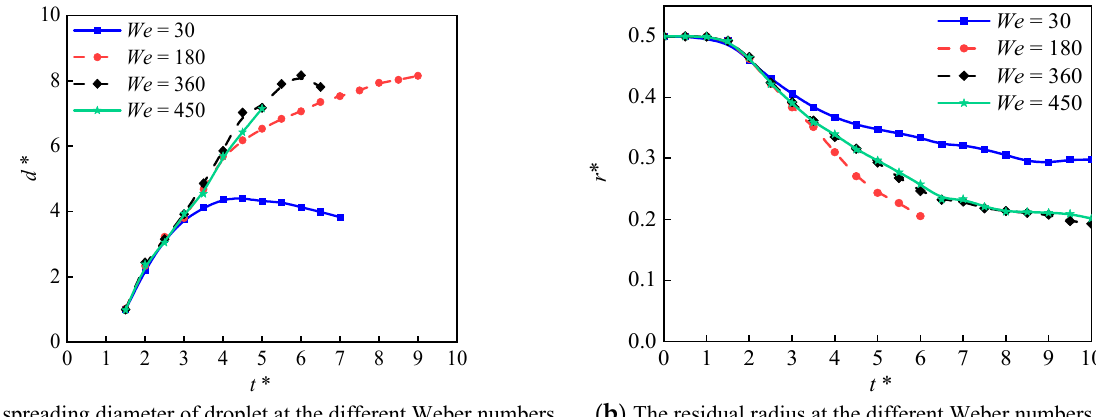
Figure 21. Effect of the Weber number on the vaporization of droplet on the smooth surface.